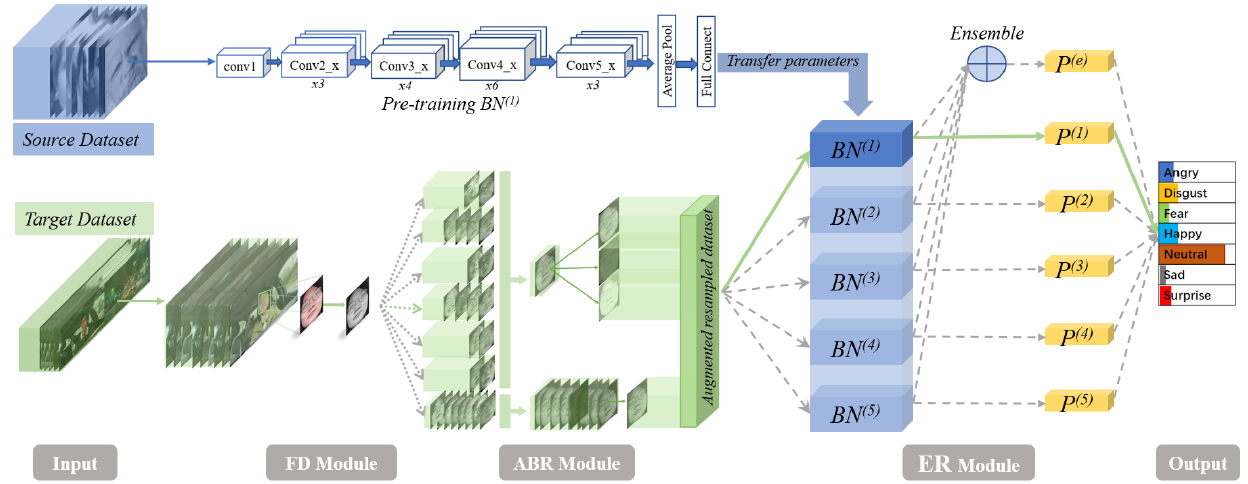
Figure 1. The overall structure of the proposed facial expression-based on-road driver emotion recognition network (FERDERnet). FERDERnet takes two inputs: source dataset (in this study: FER and CK+) and target dataset (in this study: on-road driver facial expression dataset). The flows of the source dataset are indicated by the blue arrows, while the flow of the target dataset is indicated by the green arrows. BN(i) stands for backbone networks; P(i) stands for model